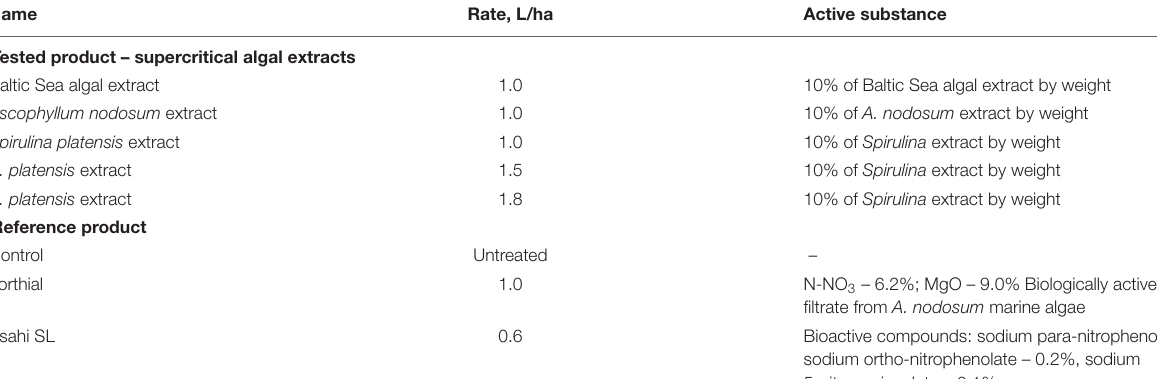
TABLE 1 | Products tested in field experiments on winter